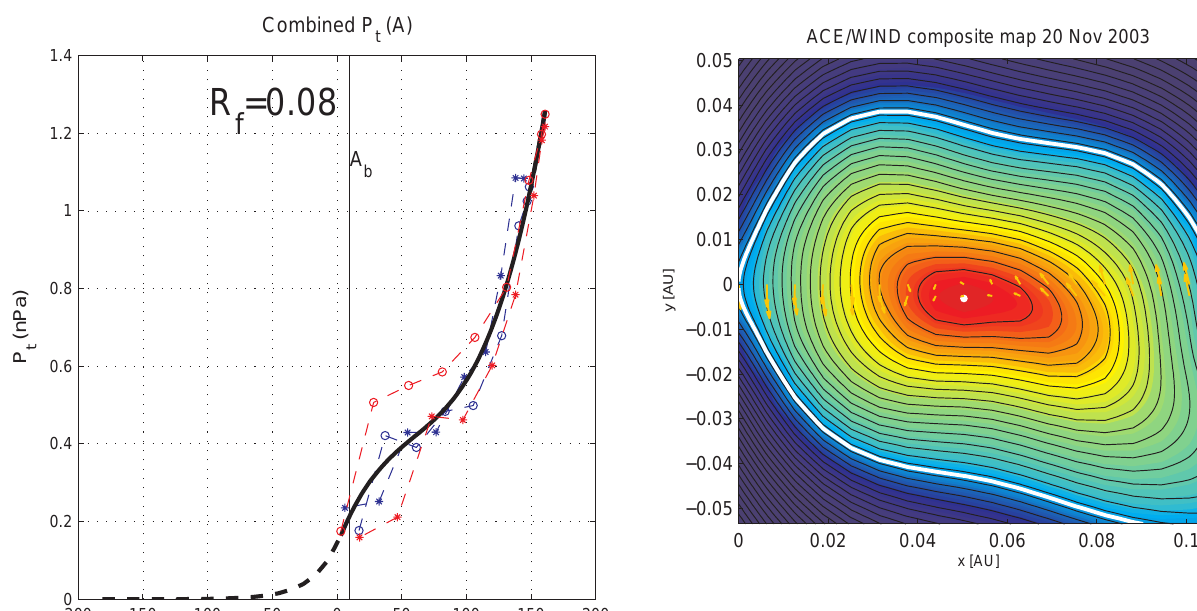
Fig. 11. Combined magnetic field map. Contour lines represent transverse magnetic field lines. B z (pointing out of the paper, along the invariant direction) is color coded, with its maximum at the white dot which corresponds to A m = 155Tm (see text). The white contour line is drawn at a value of A b = 10Tm. Yellow arrows along the spacecraft trajectory are projections of the measured field vec- tors onto the x-y plane (upper WIND, lower